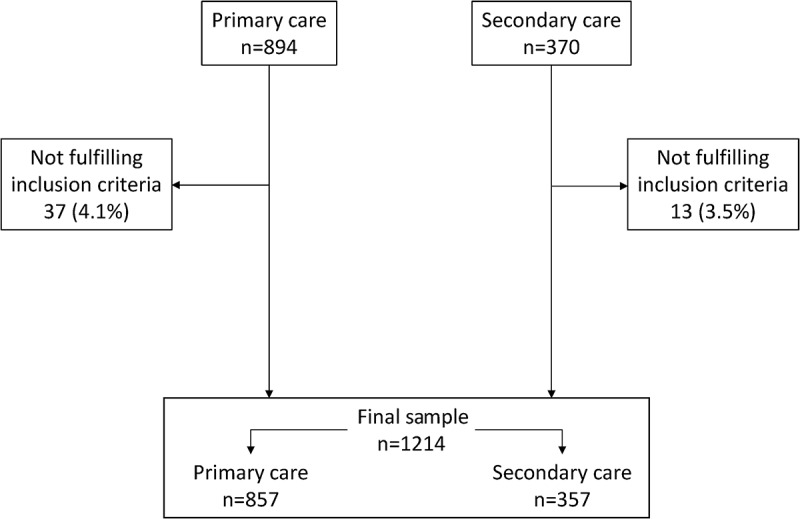
Flowchart of patients included in study.